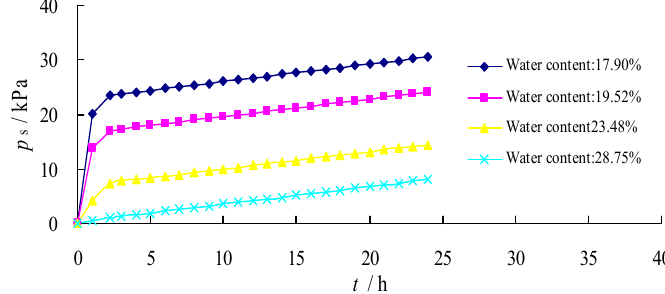
Figure 2. Process curves of expansive force during wetting.